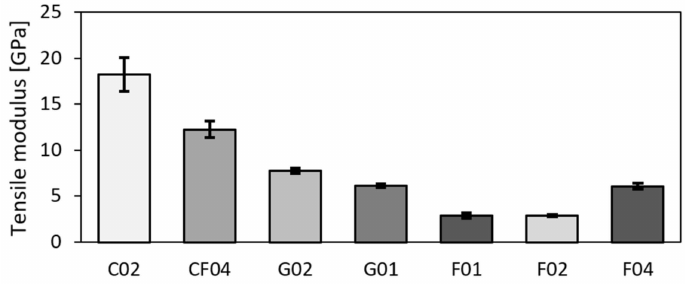
Figure 4. Tensile moduli of test